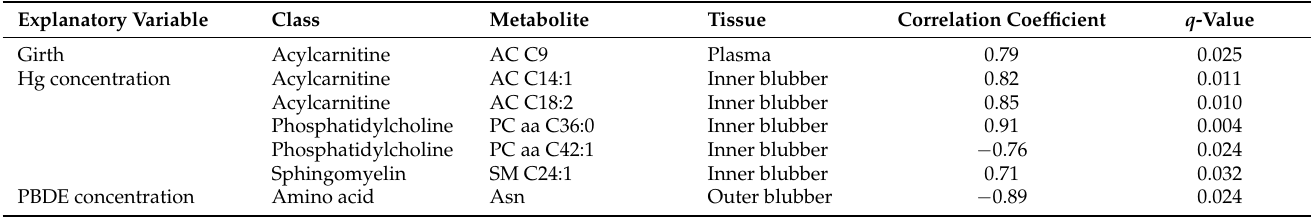
Table 4. Correlations between explanatory variables and percent contribution of metabolites quan- tified in plasma, liver, inner blubber or outer blubber of Eastern Beaufort Sea belugas. Only the correlations that were significant after a FDR adjustment are presented in this table. The full name of each metabolite can be found in Table